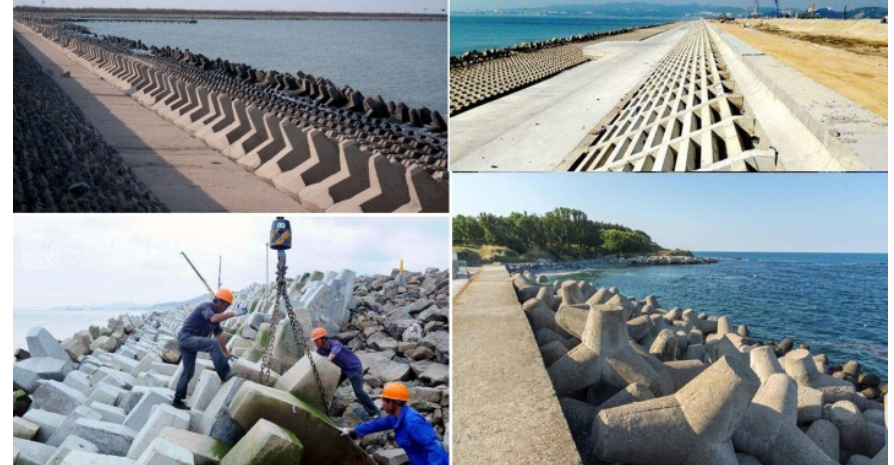
Figure 2. Sea embankment covers in the Eastern Seas of China; the blocks that composed the covers were produced with SW and SS without